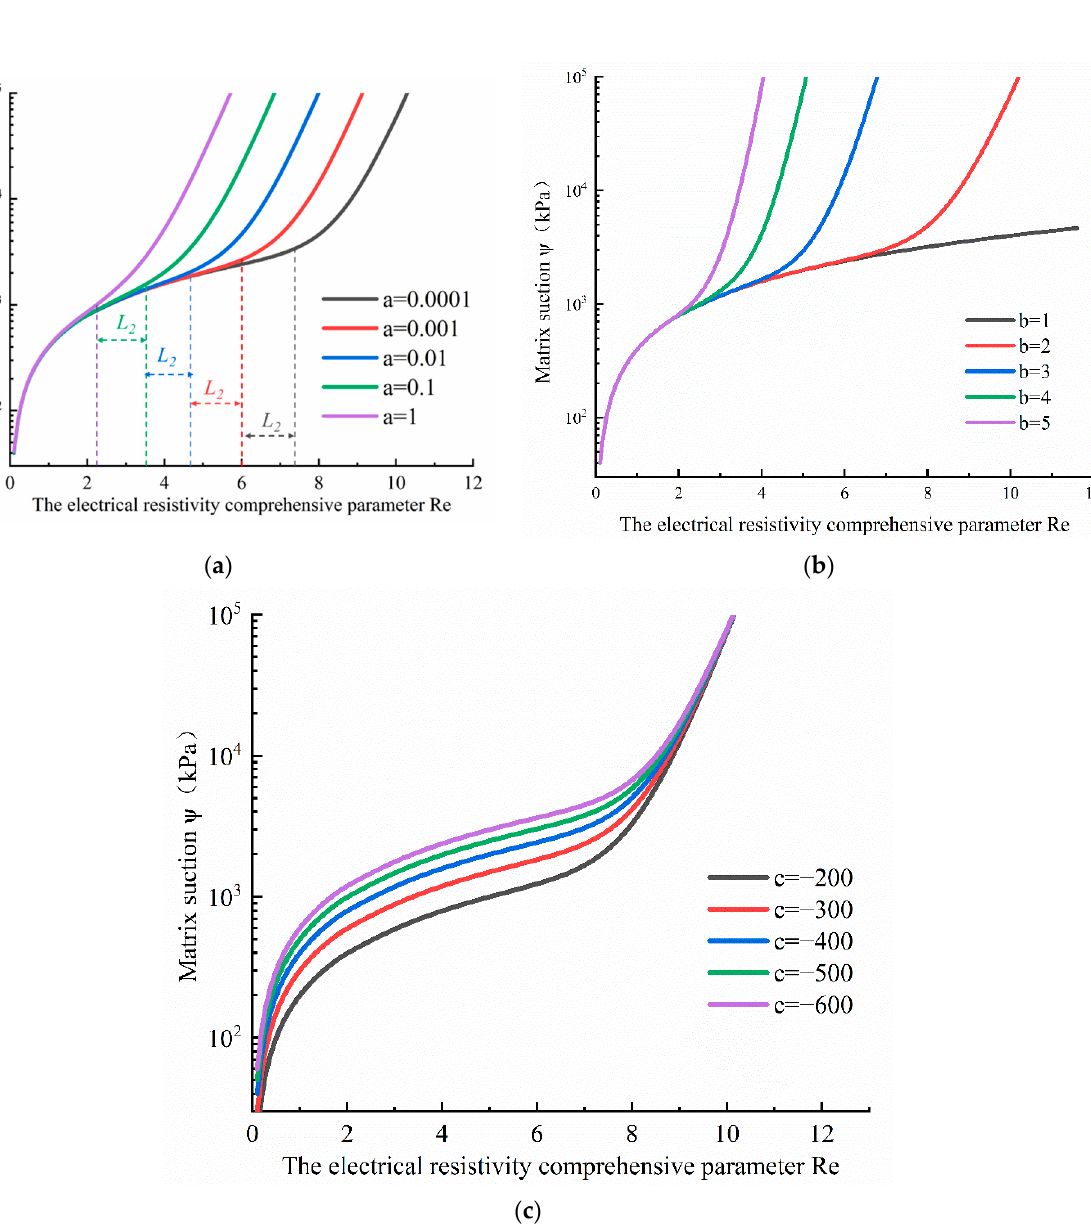
Figure 10. Sensitivity analysis of model parameters. ( a ) Parameter 𝑎 . ( b ) Parameter 𝑏. ( c ) Parameter 𝑐 .